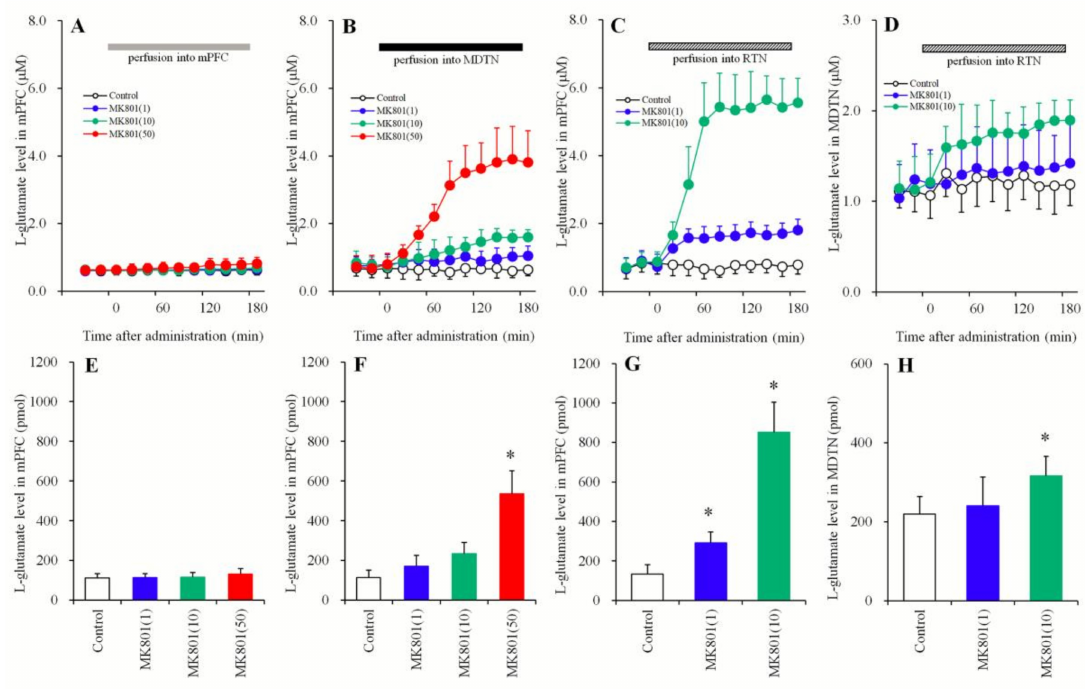
Figure 1. Concentration-dependent e ff ects of local administration (perfusion) of MK801 into the medial prefrontal cortex (mPFC) ( A , E ), the mediodorsal thalamic nucleus (MDTN) ( B , F ), and the reticular thalamic nucleus (RTN) ( C , G ) on the extracellular l -glutamate level in the mPFC and perfusion of MK801 into the RTN on the extracellular l -glutamate level in the MDTN ( D , H ). The perfusion medium commenced with MRS. After confirming the stabilization of extracellular l -glutamate levels, the perfusates in the mPFC (A: gray column), MDTN (B: black column), and RTN (CD: stripped column) were switched to MRS containing MK801 (1, 10, or 50 µ M) for 180 min. Ordinates: mean ± standard deviation (SD) ( n = 6) of extracellular l -glutamate levels ( µ M). Abscissas: time after administration of MK801 perfusion (min). Area under curve (AUC) values of l -glutamate levels (pmol) during perfusion with MK801 (from 20 to 180 min) based on ( A – D ) were indicated in ( E – H ), respectively. * p < 0.05. This is relative to the control (opened bar) using an LME with Tukey’s post hoc